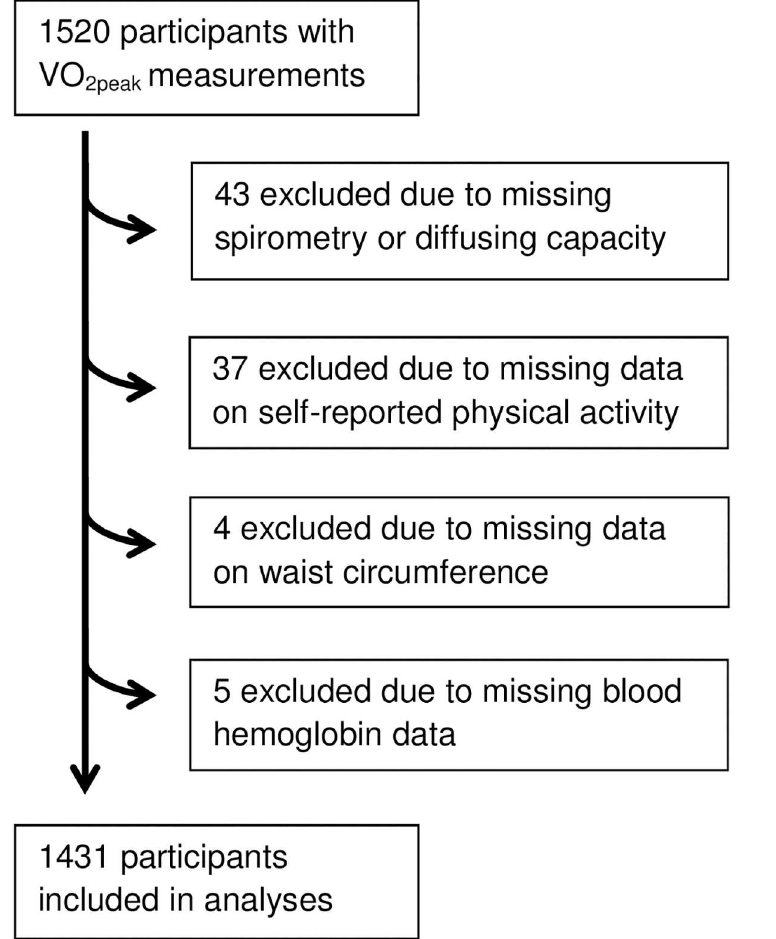
Fig 1. Flowchart showing participant excluded due to various missing